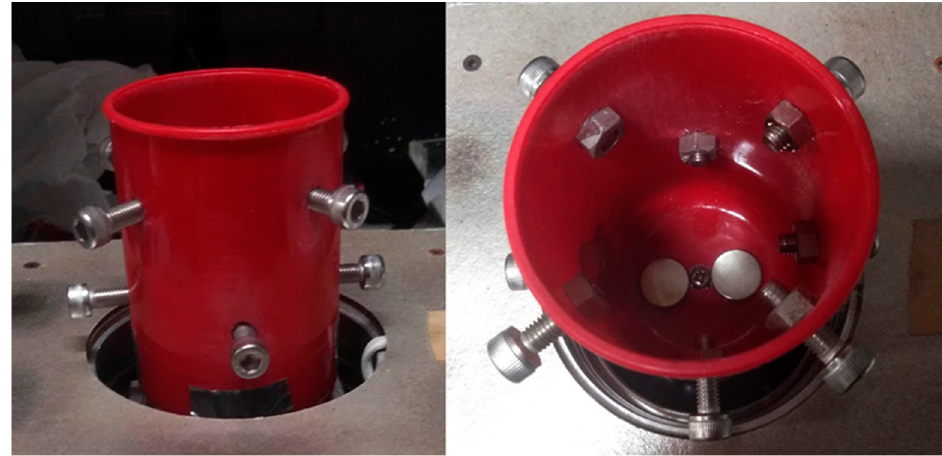
Figure 5. Cylindrical container with screws.